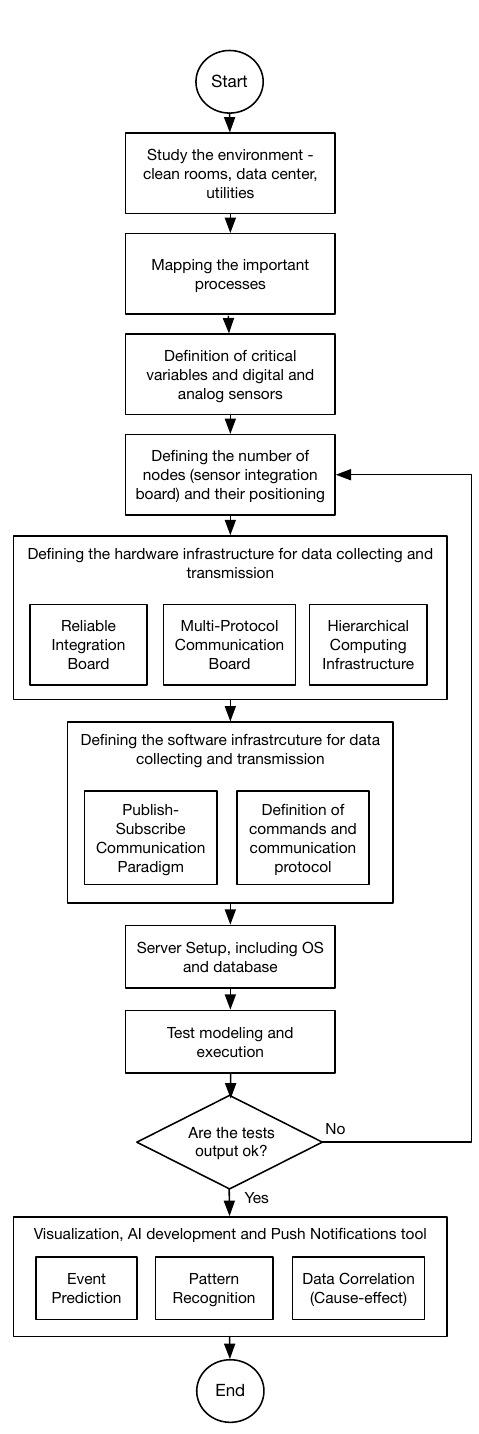
Figure 1. Pilot 4.0 reference design